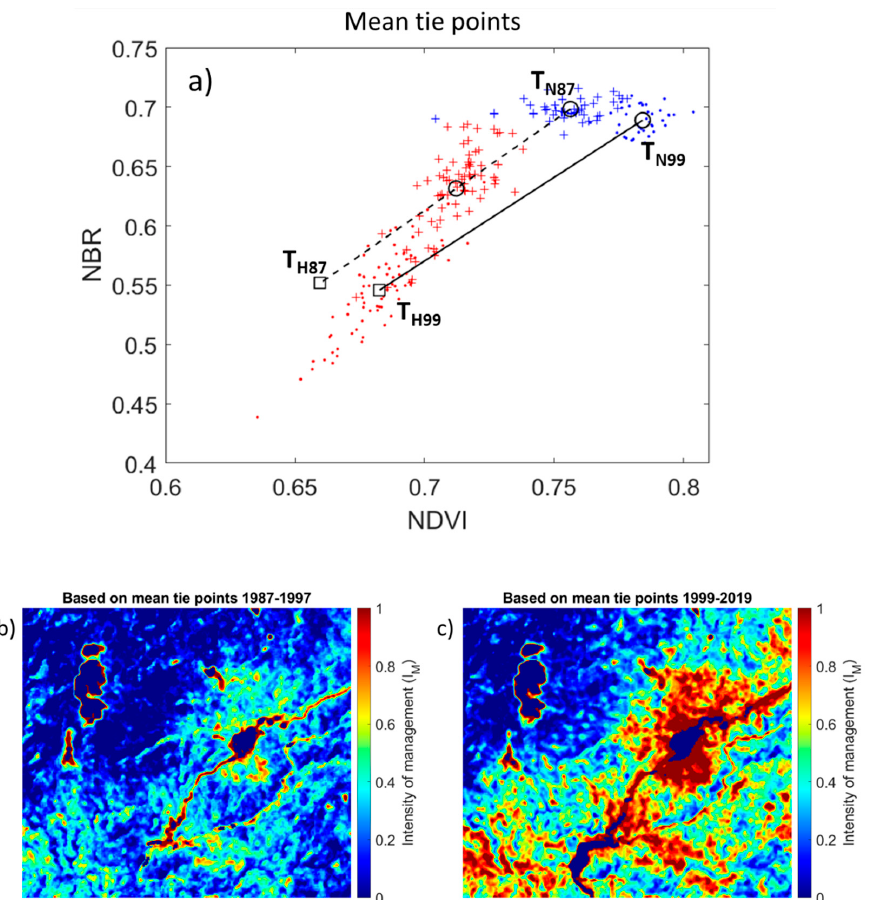
Figure 11. ( a ) Mean tie-points for NF (T N ) and HMCF ( T H ), and the intensity of management ( I m ) estimated using the tie-points for ( b ) the 1987–1997 and ( c ) 1999–2019 periods. In (a), for the 1987–1997 period, the data points for NF and HMCF sites are shown in small blue and red crosses and in a dotted line connecting the tie-points T N87 and T H87 . For the 1999–2019 period, the data points for NF and HMCF sites are shown in blue and red dots and in a solid line connecting the tie-points T N99 and T H99